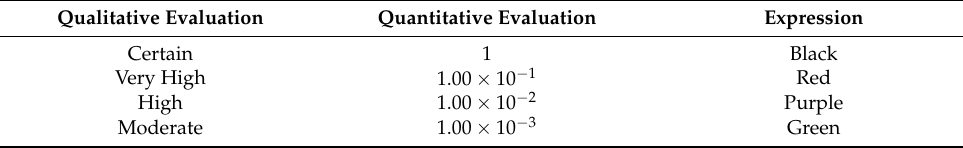
Table 7. Quantitative